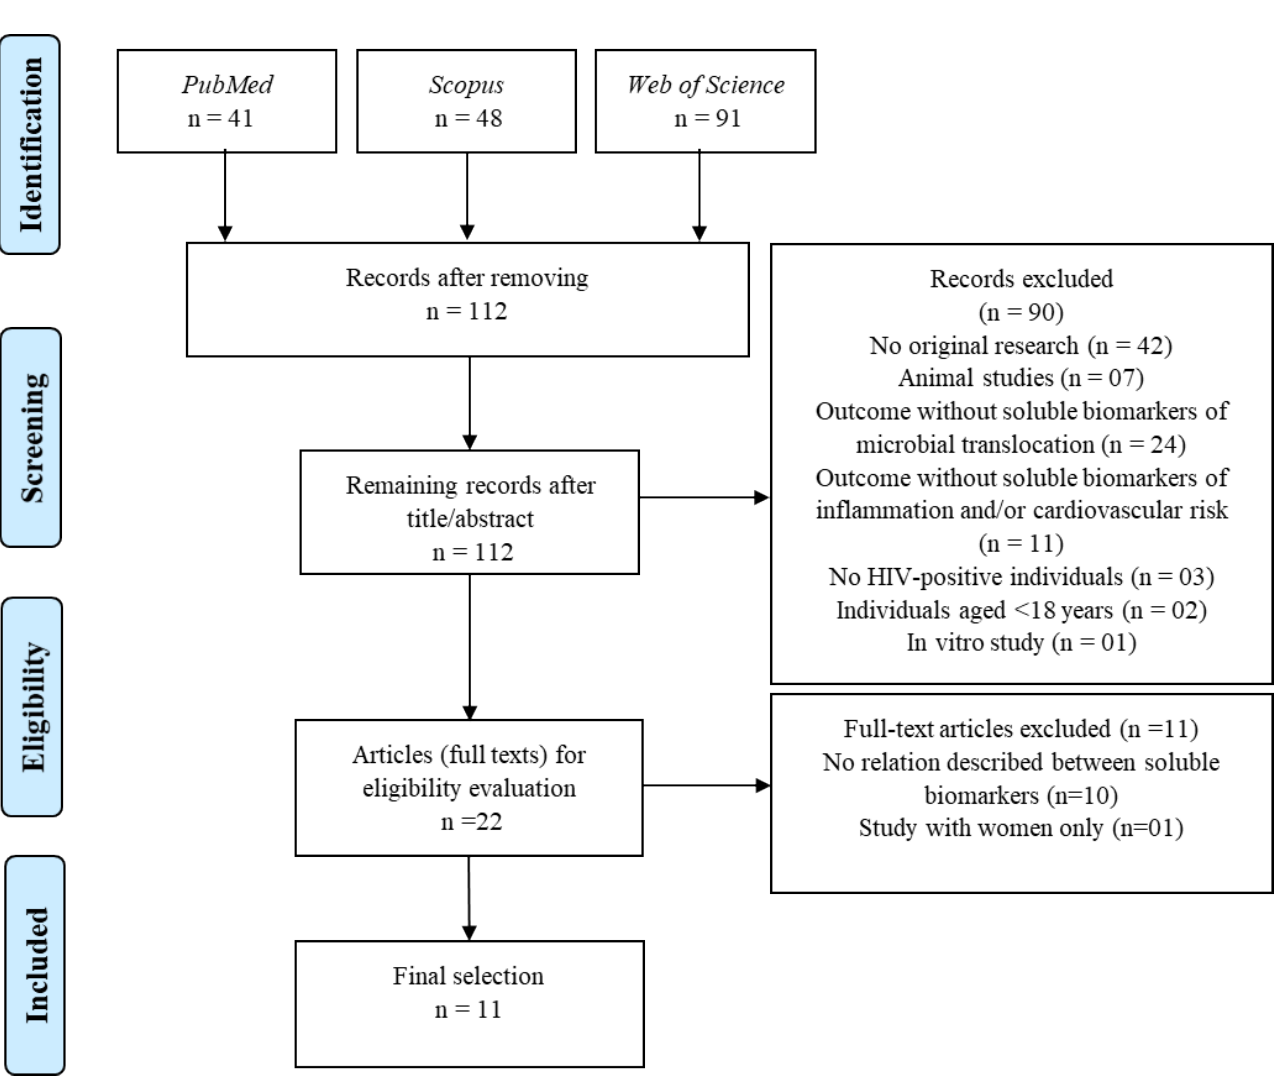
FIGURE 1 - Flowchart of study